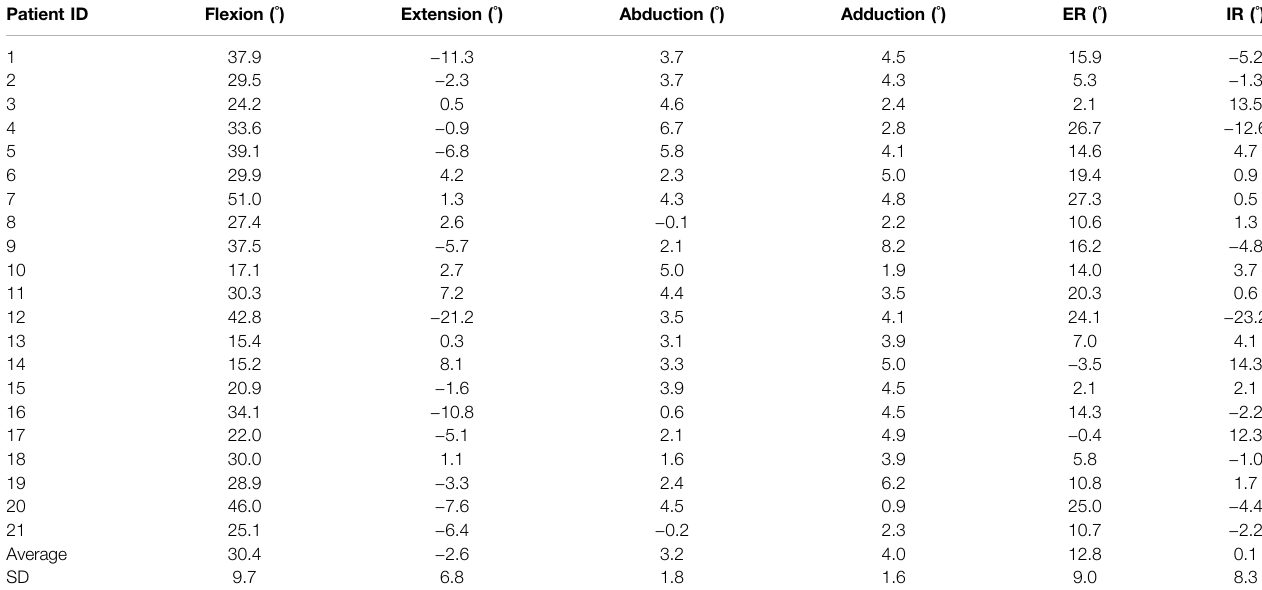
TABLE 1 | Maximum 6-DOF range of motion during